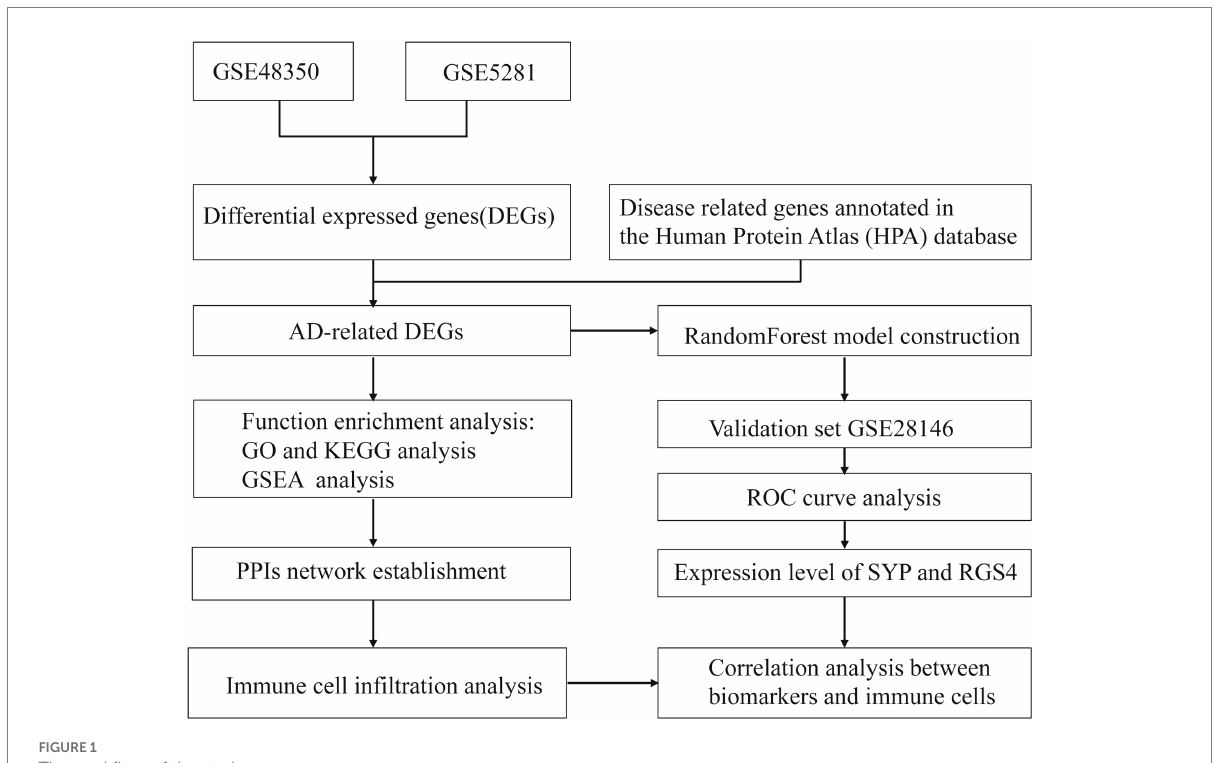
FIGURE 1 The workflow of the